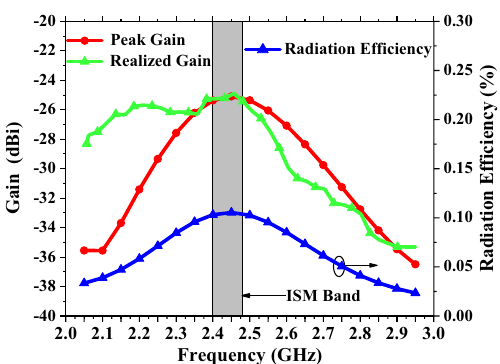
Figure 12. Graph of implantable antenna gain and radiation efficiency vs.